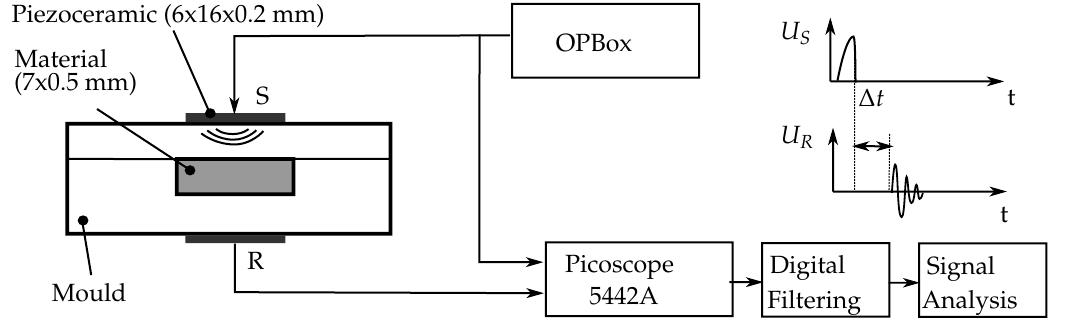
Figure 2. Measurement chain of the ultrasonic experiments applied in this